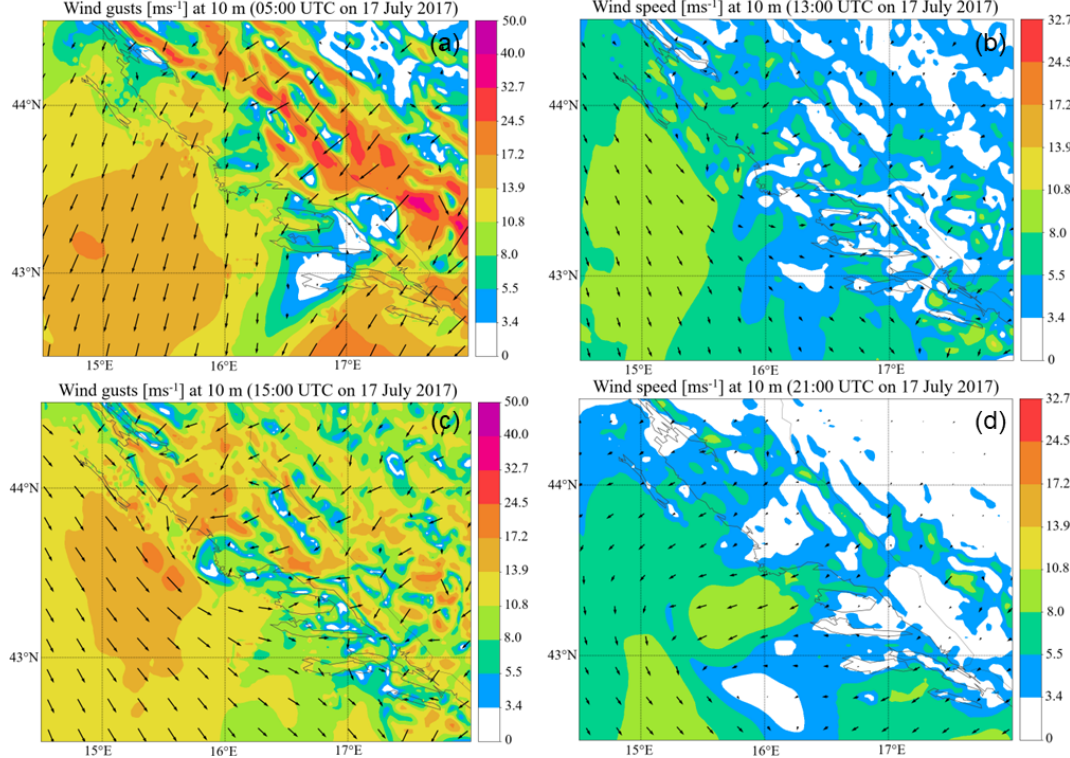
Figure 11. (a) Wind gusts (ms − 1 ; vector and colored contour) at 05:00UTC, (b) winds (ms − 1 ; vector and colored contour) at 13:00UTC, (c) wind gusts (ms − 1 ; colored and array) at 15:00UTC, and (d) wind speed (ms − 1 ; colored and array) at 21:00UTC, all valid for 17 July 2017 at 10m from the ALADIN-HRDA